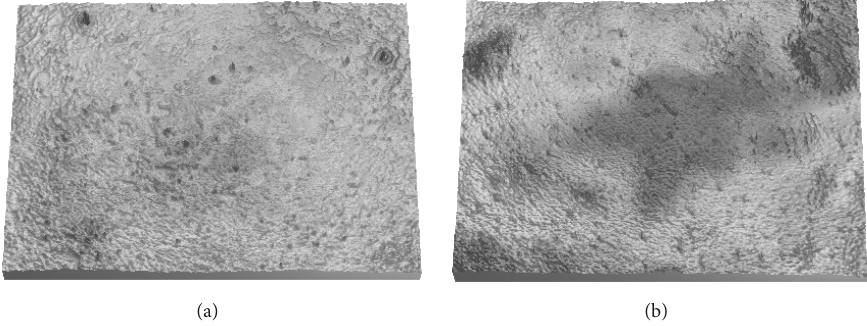
Figure 7: Surface topography of (a) untreated sample and (b) plasma treated (size of image 1.3 × 0.94 mm). Table 3: The centration of functional groups on the surface from XPS for the untreated and plasma treated samples. Name % at cont.